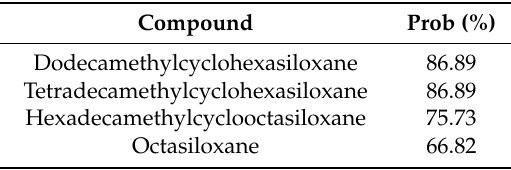
Table 4. Potential plasticizers identified using